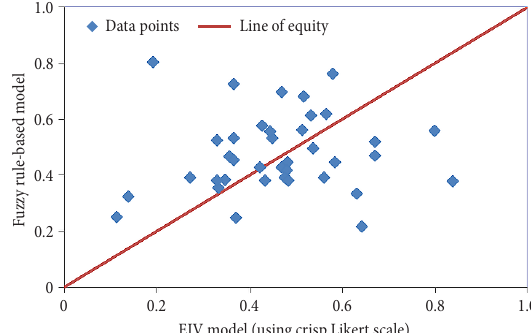
Fig. 3. Scatter plot of workers’ motivation calculated using EIV method and fuzzy rule-based model